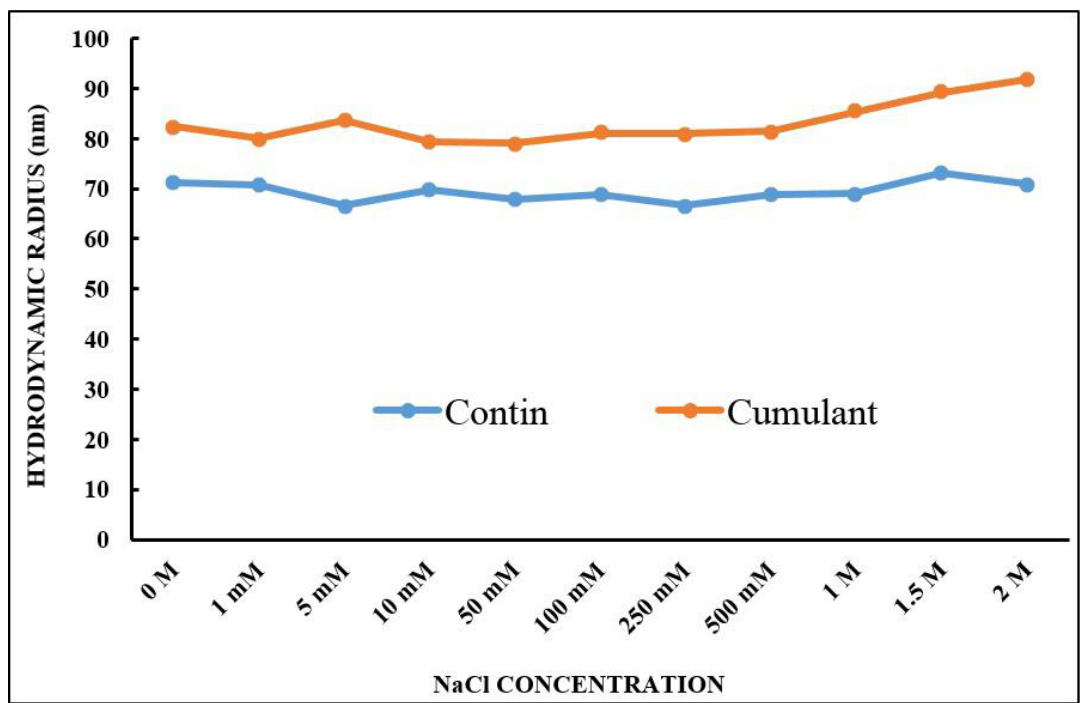
Figure 4. The hydrodynamic radius of NH 2 -PEO-PCL nanoparticles as a function of NaCl concentration.